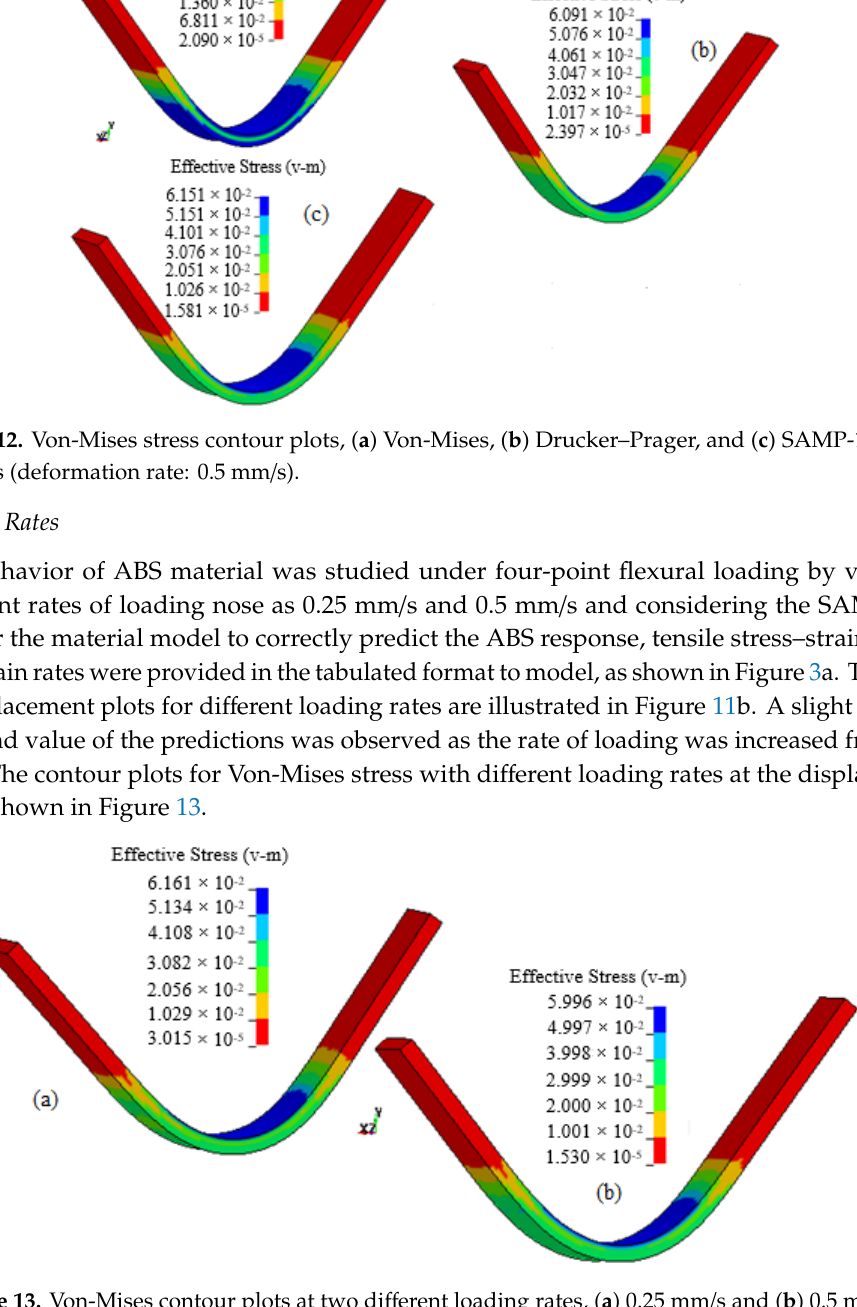
Figure 13. Von-Mises contour plots at two different loading rates, ( a ) 0.25 mm/s and ( b ) 0.5 mm/s.